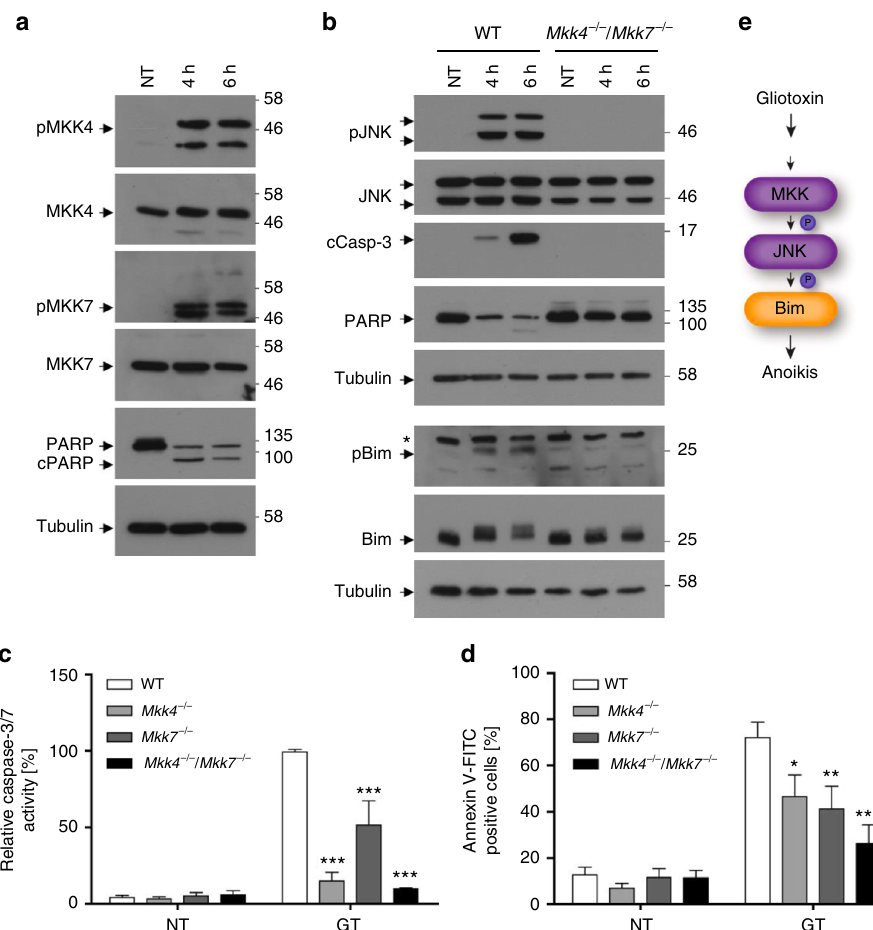
Fig. 1 MKK4 and MKK7 are required for GT-induced anoikis. a Western blot analysis of total extracts of human bronchial epithelial cells (BEAS-2B) showing increased phosphorylation of MKK4 (Ser257/Thr261) (pMKK4) and MKK7 (Ser271/Thr275) (pMKK7) as well as PARP cleavage (PARP/cPARP) after GT treatment for 4 and 6 h. b Western blot analysis showing increased phosphorylation of JNK (T183/Y185) (pJNK) and Bim (T112/S114) (pBim) and enhanced processing of caspase-3 and PARP in total extracts of WT MEFs treated with GT for 4 and 6 h. None of these changes were seen in the extracts of non-treated (NT) cells or MEFs de fi cient for both Mkk4 and Mkk7 ( Mkk4 − / − /Mkk7 − / − ). c , d MEFs de fi cient for either Mkk4 ( Mkk4 − / − ), Mkk7 ( Mkk7 − / − ) or both Mkk4/Mkk7 ( Mkk4 − / − /Mkk7 − / − ) exerted reduced caspase-3/7 activity ( c ) and annexin V-FITC staining ( d ) and as compared to wild- type (WT) cells when treated with GT for 6 h. e Schematic representation of how GT activates MKK4/MKK7 (MKK) and triggers JNK/Bim-mediated anoikis. Tubulin was used as loading control in a and b . Graphs in c and d show the means of at least three independent experiments ± s.e.m.; p